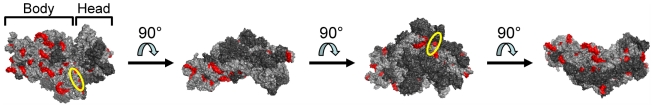
Distribution of potential sites for base-pairing of C-rich RBSs to 16S rRNA.Regions on the E. coli 30S ribosomal subunit with significant complementarity to the 30-5-3 library (p-value<0.01; Bonferroni-corrected) were determined. Significant seven-base windows that shared six bases with at least one neighboring significant window are highlighted in red (PyMOL rendering of PDB 3DF1). Four different views are shown to convey the general distribution of these potential base-pairing sites over the small ribosomal subunit. The first view shows the face that becomes buried after assembly with the large ribosomal subunit. The yellow ellipse indicates the approximate position of the anti-SD sequence. 16S rRNA = light gray; ribosomal proteins = dark gray.